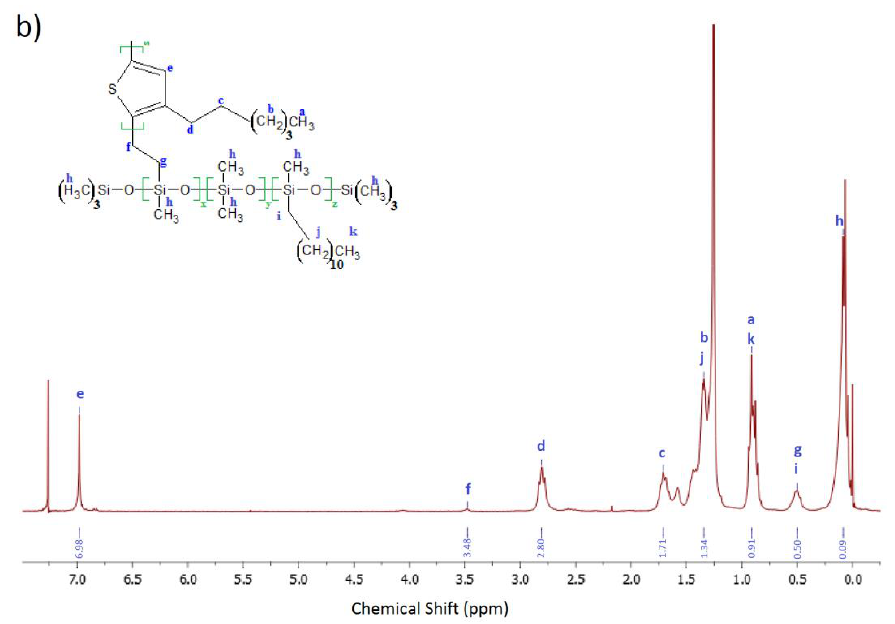
Figure A1. 1 H Nuclear Molecular Resonance ( 1 H-NMR) spectra of ( a ) PEGSil CH; ( b ) DodecSil CH. Marked by letters of the hydrogen atoms group assigned to particular observed signal groups visible in the 1 H-NMR spectrum. Polymers ’ macroparticles schemes are shown in the spectrograms.